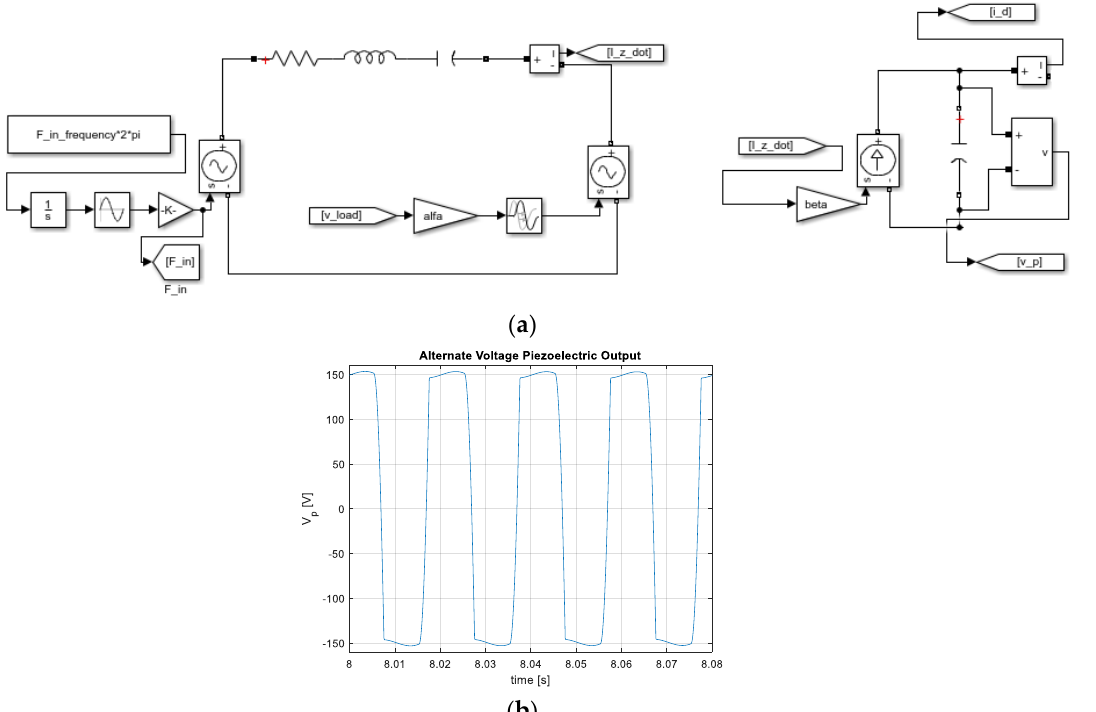
Figure 9. Simulink ® model for the PZT equivalent electric circuit ( a ) and voltage output of the PZT layer ( b ). layer ( b